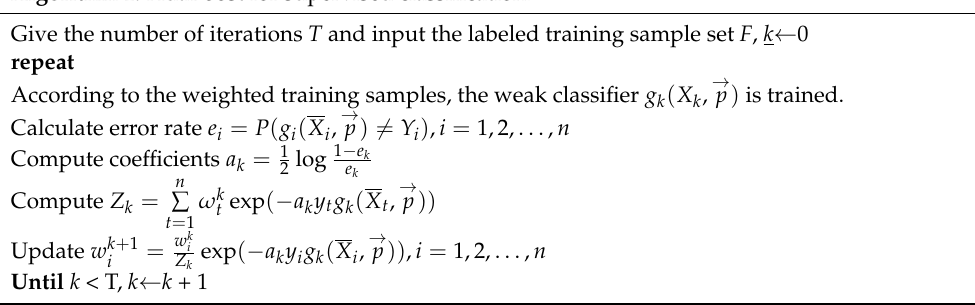
Algorithm 1: AdaBoost for supervised